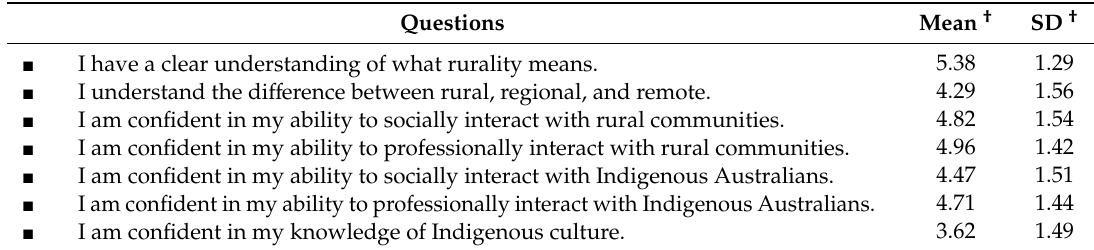
Table 1. First-year dental students’ perception and understanding of rural environment. Questions